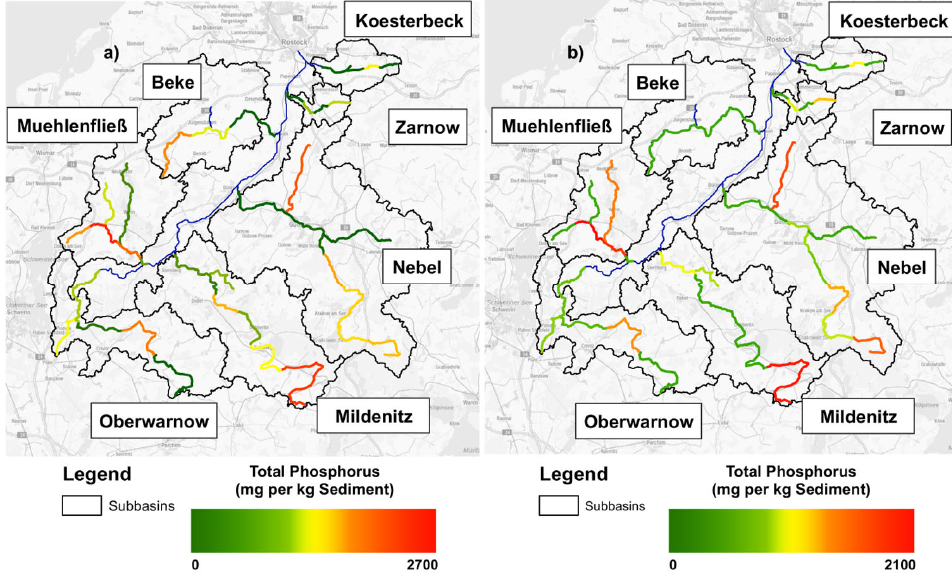
Figure 4. Map of the total P distribution in the Warnow River Basin in the ( a ) top (0–2 cm) and ( b ) bottom (2–10 cm) sediment layer.